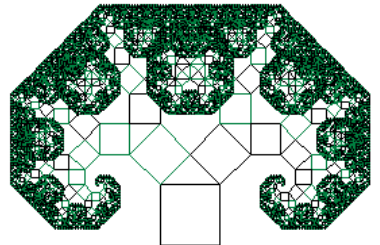
Figure 27. Pythagorean tree constructed using IFS in Equations